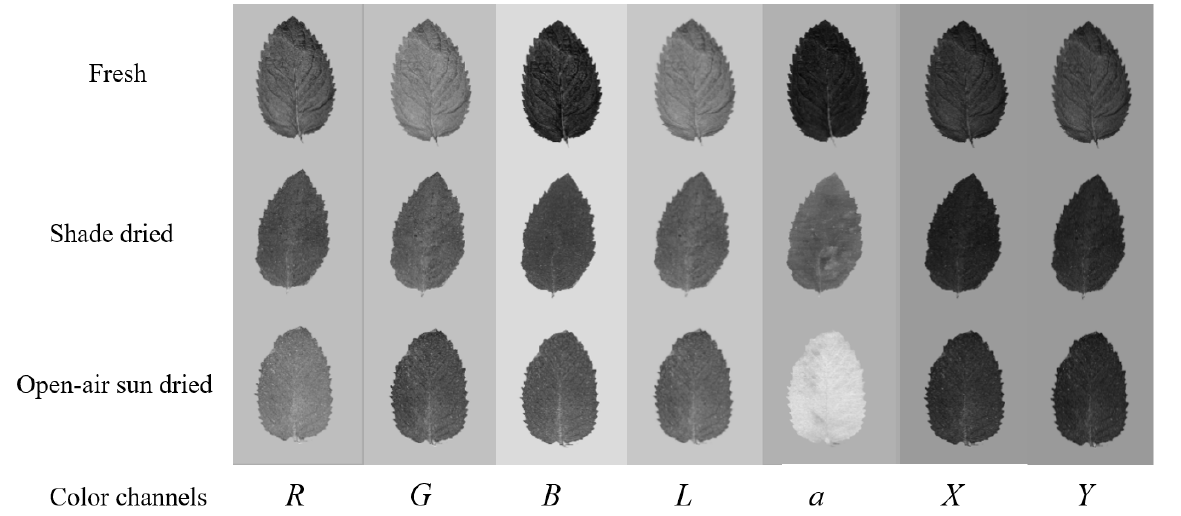
Figure 3. The images of the ventral side (upper surface) of fresh and dried mint leaves in selected color channels R , G , B , L , a , X , and Y .